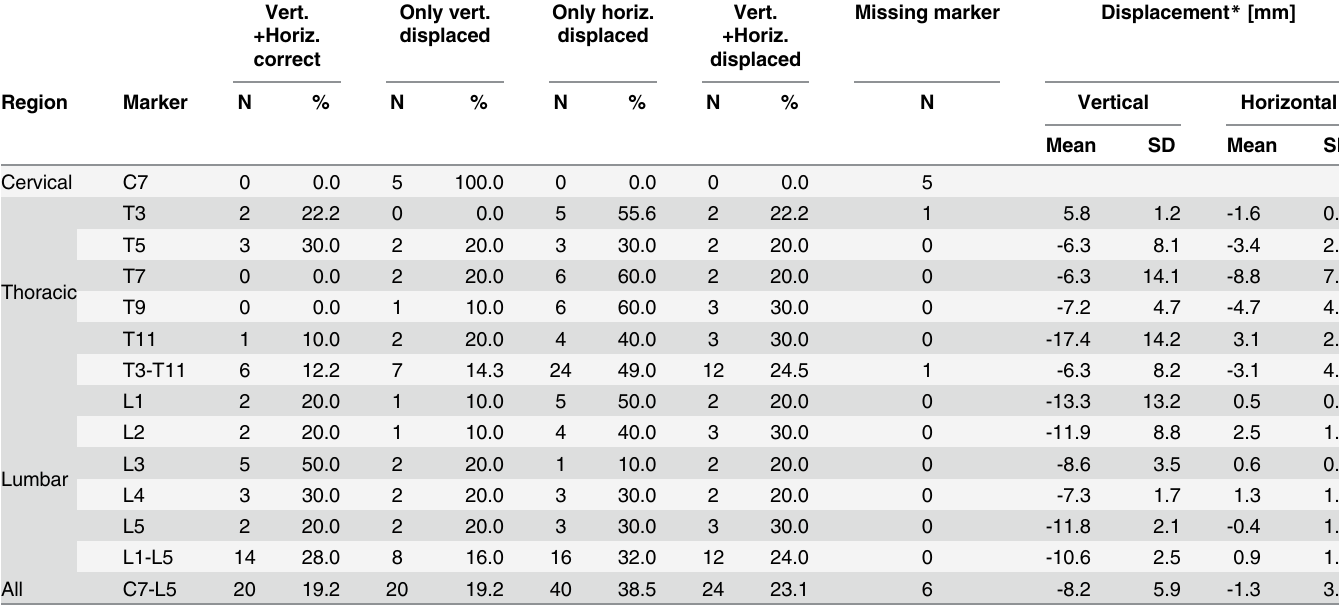
Table 2. Accuracy of spinous process identification by palpation.